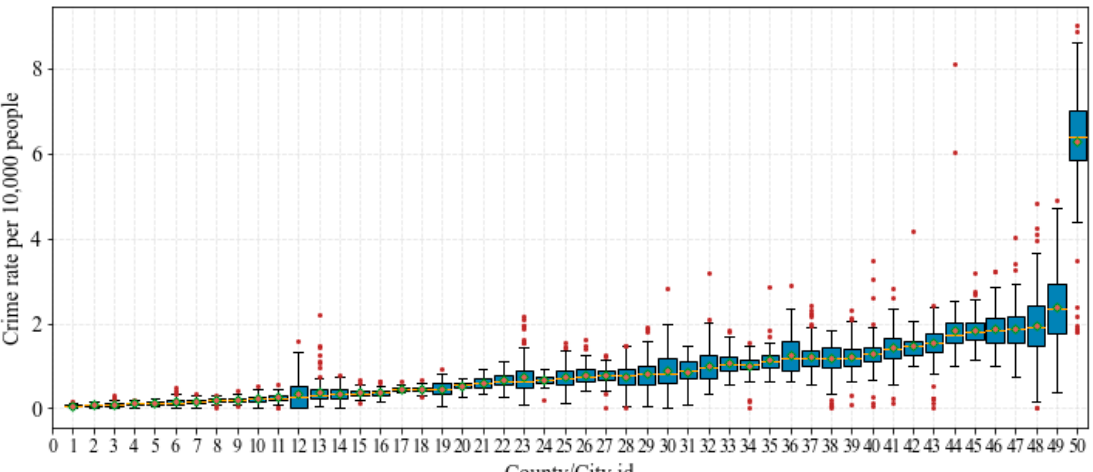
Figure 3. Boxplot of the total crime rate per 10,000 people including outliers (red circles), mean values of crime rates (orange circles), and median value of crime rates (yellow lines inside boxes).